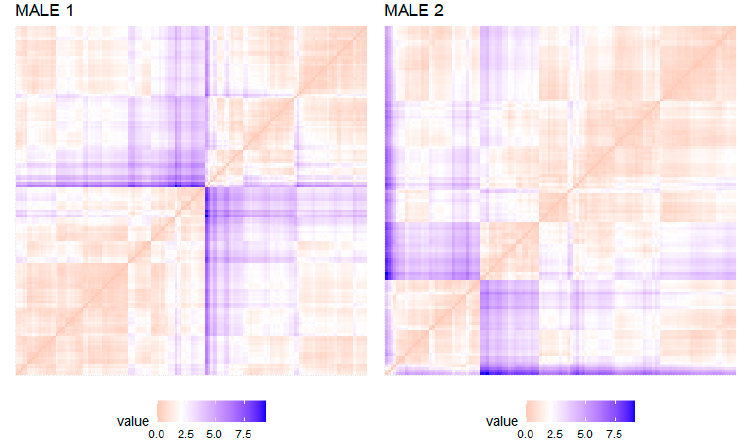
Figure 2. Quality of clustering based on Visual Assessment of the cluster Tendency (VAT) in sperm population of two bottlenose dolphin ( Tursiops truncatus ) (Male 1—left panel; Male 2—right panel). The cuvette visually detects the clustering trend by counting the number of square orange blocks along the diagonal in a cuvette image. Orange indicates high similarity (values close to 0), while blue indicates low similarity (values higher than 2.5).